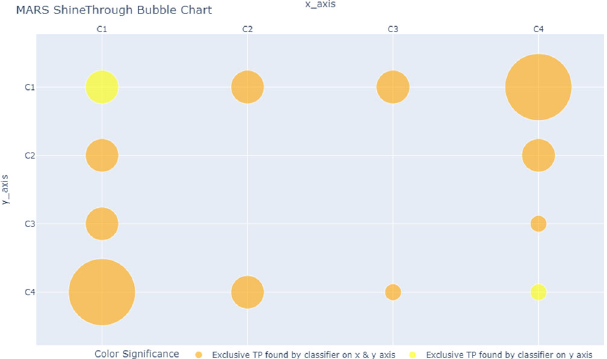
Figure 2. MARS ShineThrough Chart, comparing count (represented by bubble radius) of target-class obser- vations (True Positives) exclusively spotted by classifiers C1 and the pairwise classifier combinations. Bubble size is proportional to ShineThrough score: the larger the bubble, the higher the classifier(s) ShineThrough